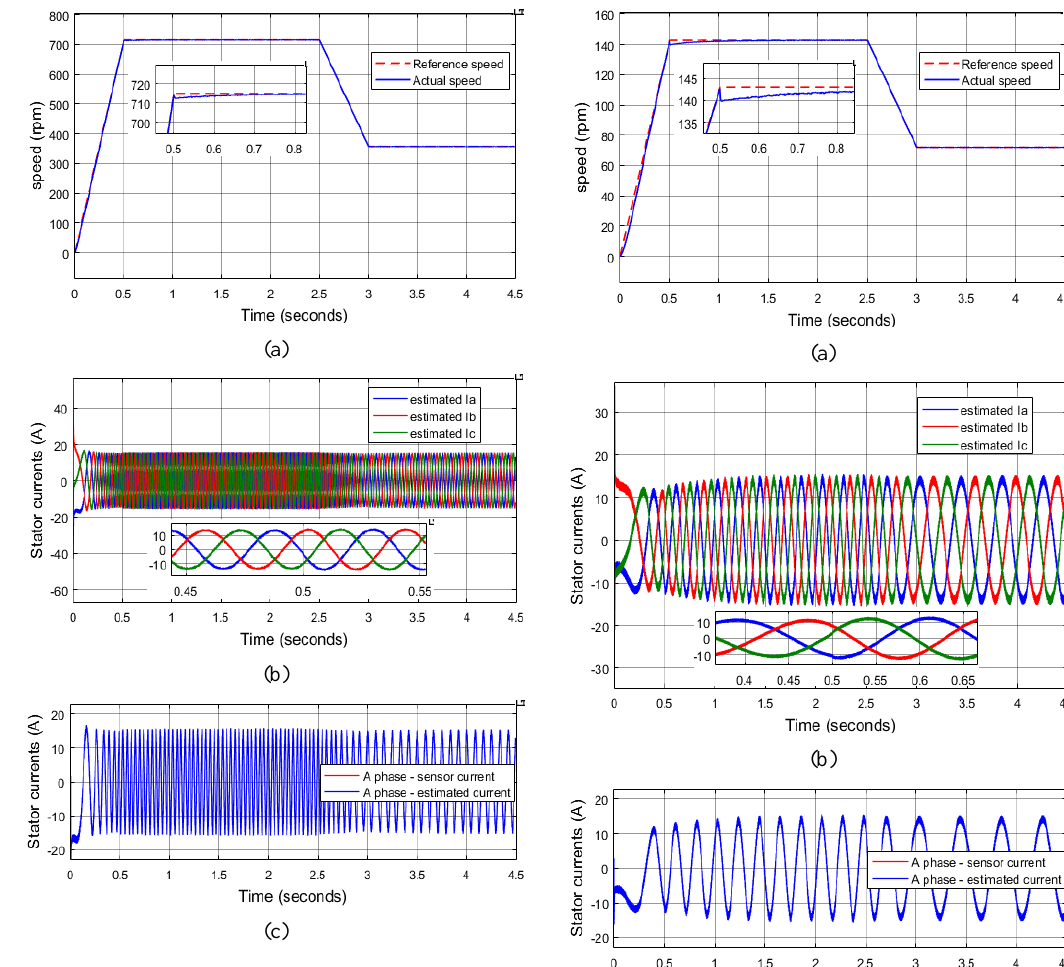
Fig. 8. HPWM technique without current sensors at 5 (N.m) load torque: (a) Reference and actual speed at 50% - 25% rating speed, (b) Three phase estimated currents, (c) Comparison between A-phase measured current and estimated current. Fig. 9. HPWM technique without current sensors at 5 (N.m) load torque: (a) Reference and actual speed at 10% - 5% rating speed, (b) Three phase estimated currents, (c) Comparison between A phase measured current and estimated current.